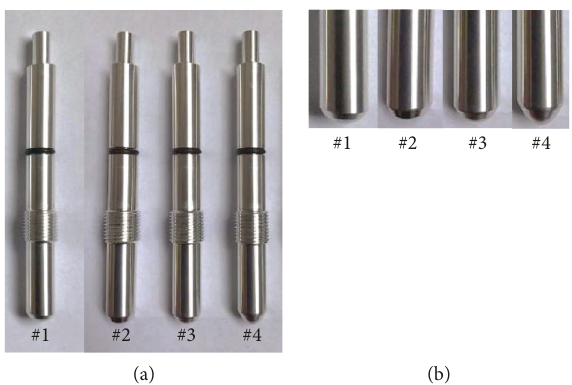
Figure 8: The actual test spool. (a) The actual value spool. (b) Enlarged view of spool head.